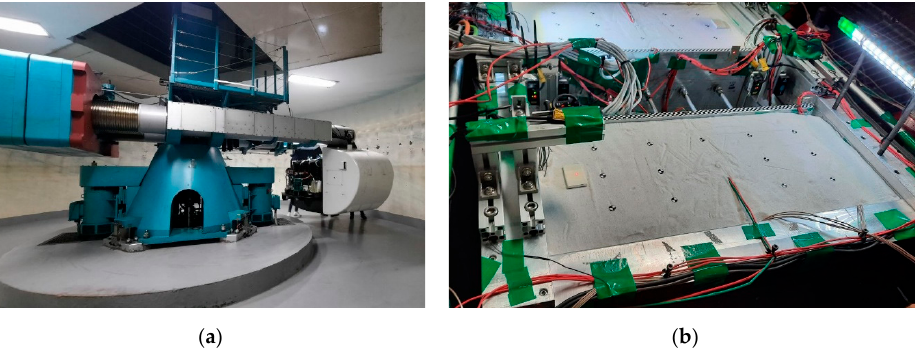
Figure 1. Centrifugal test: ( a ) KOCED centrifuge at KAIST; ( b ) centrifugal strutted-excavation model.